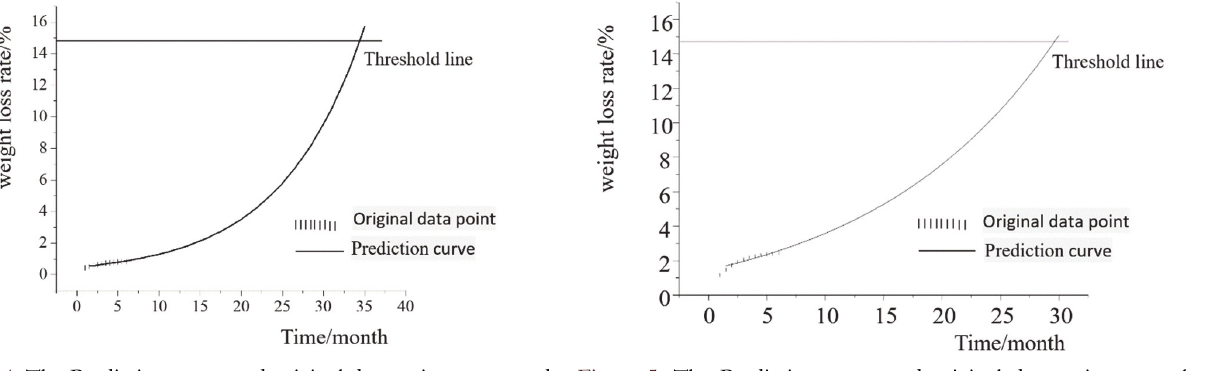
Figure 4. The Prediction curve and original data point at wet and dry alternately environment.